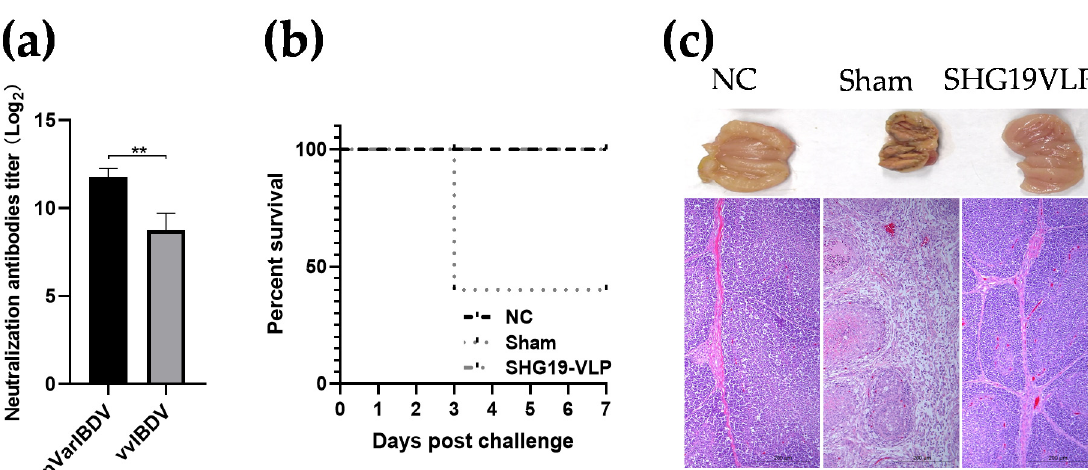
Figure 3. Evaluation of the immune effect of the SHG19-VLP vaccine against vvIBDV. ( a ) Serum neutralization antibody titers at 13 days post-vaccination. The average values and standard deviations (error bars) from different independent samples are shown; Asterisk sign was used to determine statistical significance among different groups (** p < 0.01); ( b ) Survival curve. ( c ) The gross appearance (upper side) and corresponding histopathological appearance (lower side) of the bursal sections (hematoxylin and eosin staining) at 7 days post-challenge.